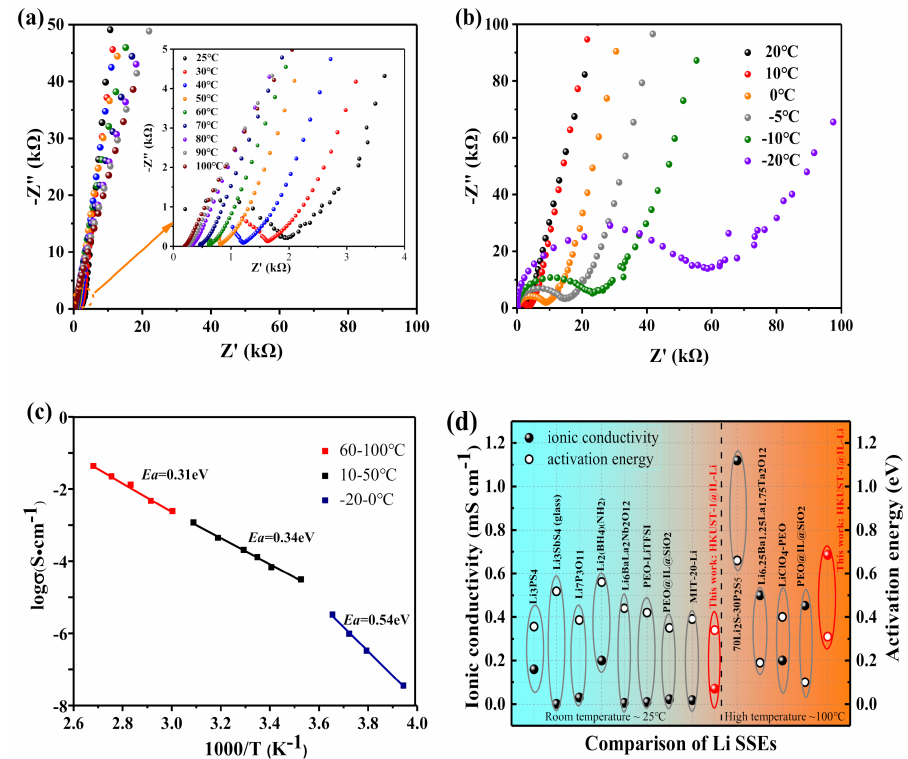
Figure 3. Lithium ion conductivity of HKUST-1@IL-Li ionic conductors: Nyquist plots of at different temperatures of ( a ) 25–100 ◦ C and ( b ) − 20–20 ◦ C. ( c ) Arrhenius plots and corresponding Ea values of electrolyte under different temperature ranges. ( d ) Ionic conductivities and activation energies of HKUST-1@IL-Li electrolyte at room and high temperature in comparison with representative electrolytes: sulfides electrolytes Li 3 PS 4 [28], Li 3 SbS 4 (glass) [29], and 70Li 2 S-30P 2 S 5 [30]; oxide electrolyte Li 7 P 3 O 11 [31]; complex hydrides electrolyte Li 2 (BH 4 )(NH 2 ) [32]; ceramic electrolytes Li 6 BaLa 2 Nb 2 O 12 [33]; and Li 6.25 Ba 1.25 La 1.75 Ta 2 O 12 [34]; polymeric electrolytes PEO-LiTFSI [35], LiClO 4 -PEO [36], and PEO@IL@SiO 2 [35], and MOF based electrolyte: MIT-2-Li [20].